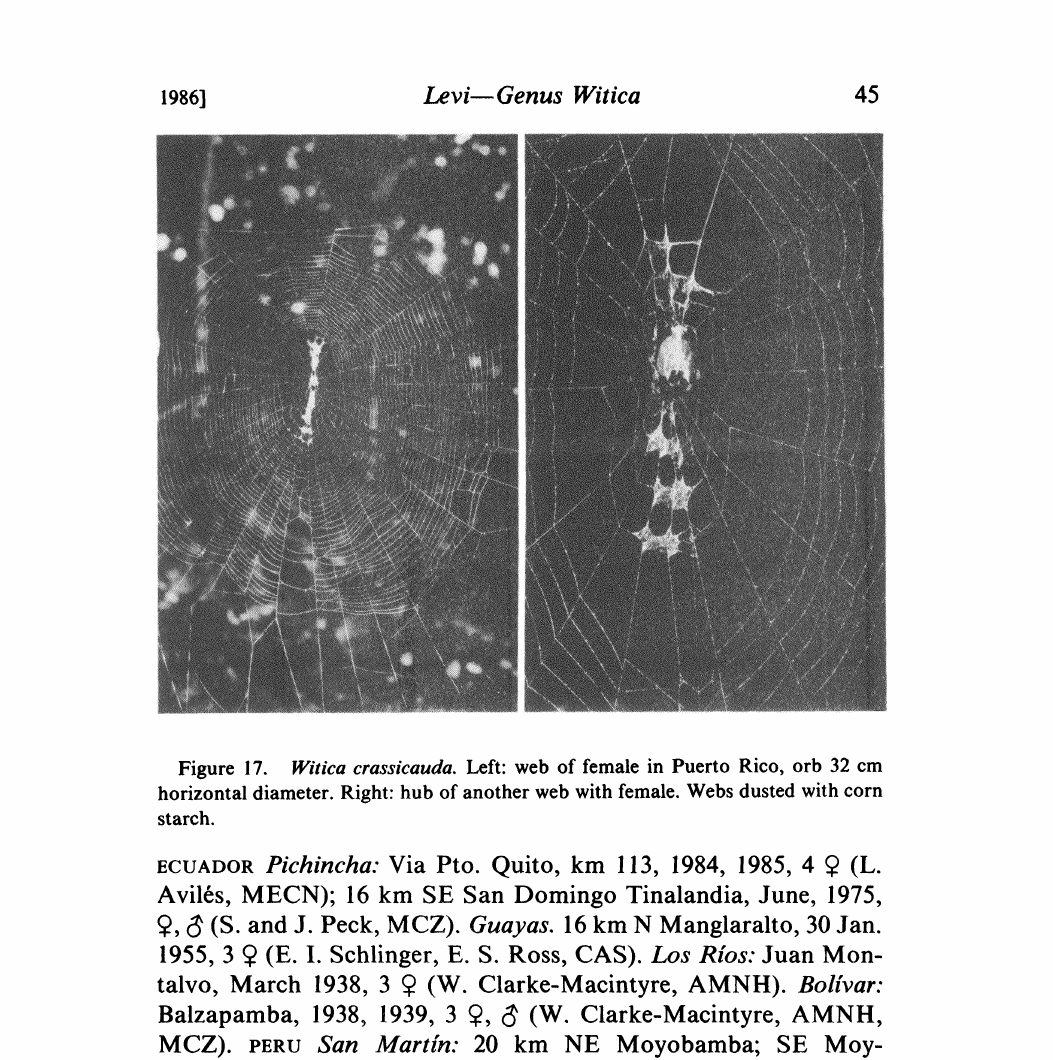
Figure 17. Witica crassicauda. Left: web of female in Puerto Rico, orb 32 cm horizontal diameter. Right: hub of another web with female. Webs dusted with corn